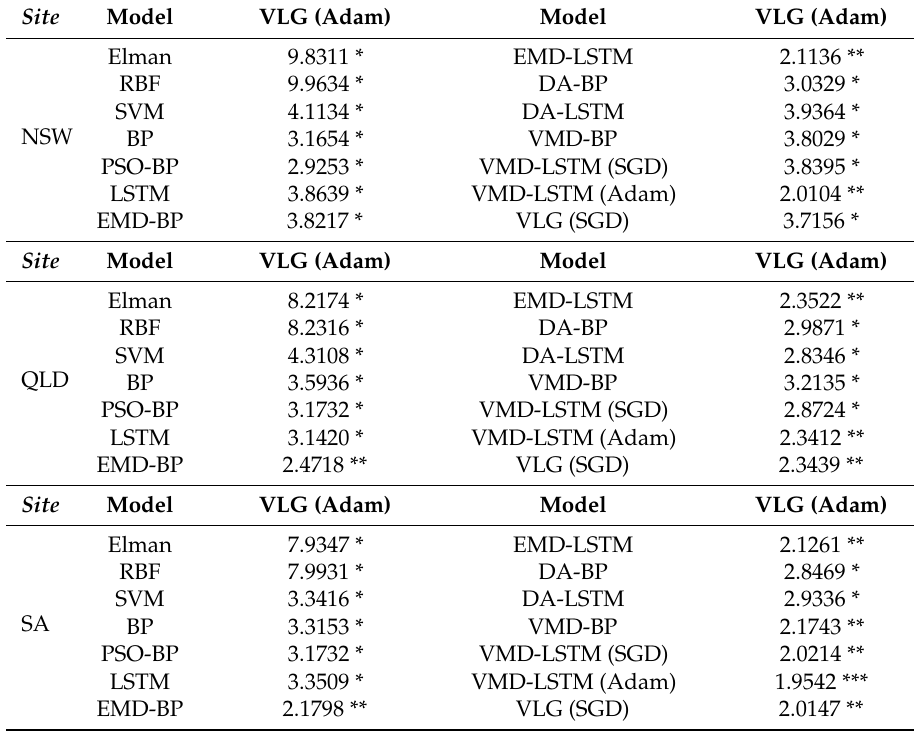
Table 13. The Diebold-Mariano test results for each